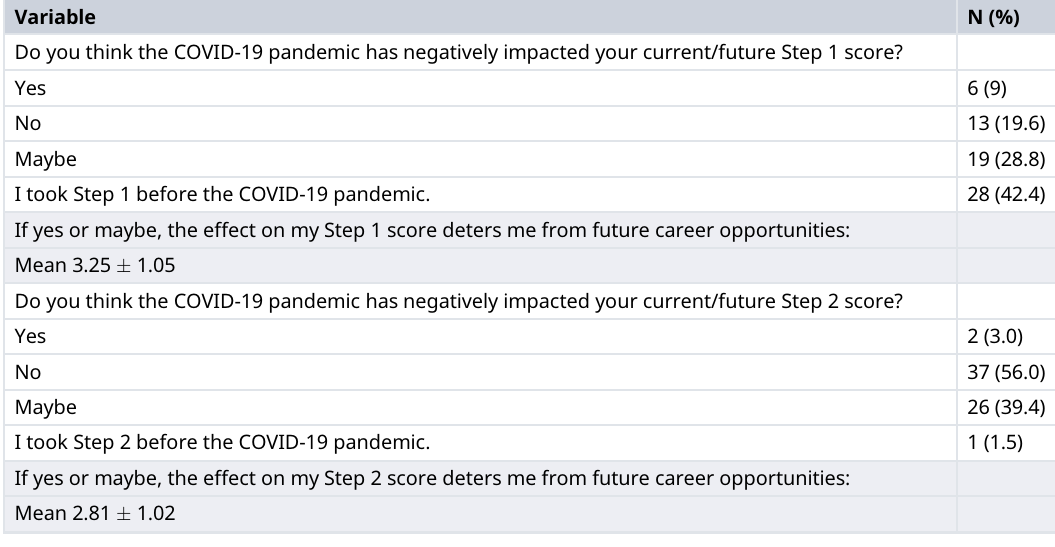
Table 4. Pandemic effects on licensing exams experienced by medical students. Variable N